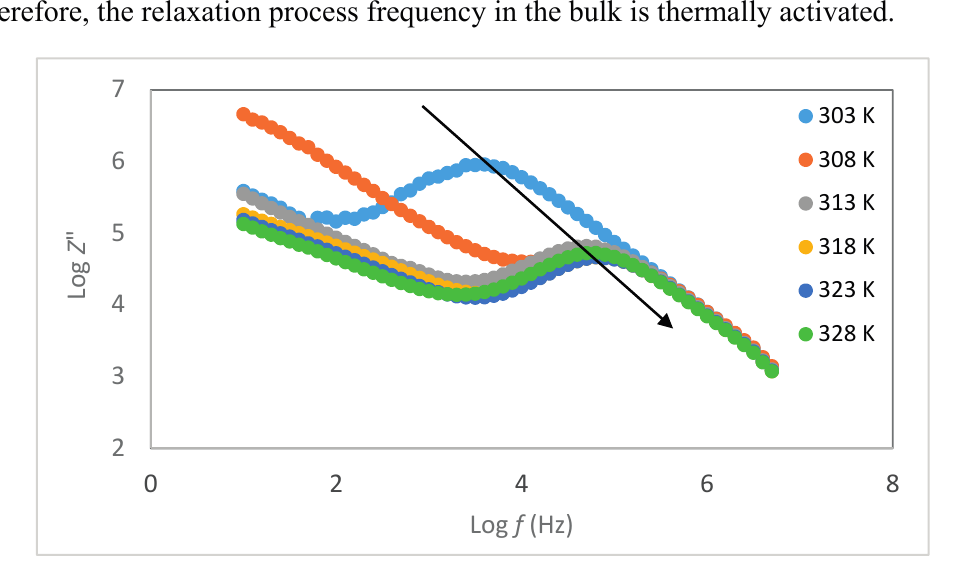
Figure 4. Frequency dependencies of Im( Z ) of P(MMA-co-EMA) + 10 wt% NaI at different temperatures.